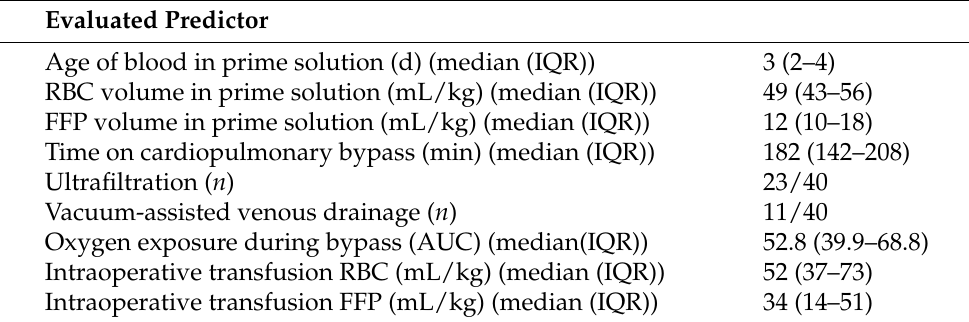
Table 2. Evaluated predictors of cell-free hemoglobin exposure and scavenger protein resources. IQR = inter-quartile range, RBC = red blood cell, FFP = fresh frozen plasma, AUC = area under